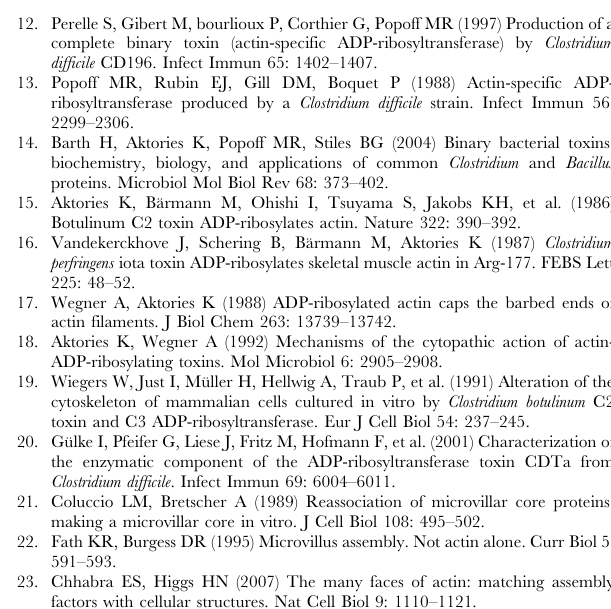
(green) by using anti-CLIP-115 antibody in Caco-2 cells are shown. The nucleus was stained by DAPI (blue). Scale bar represents 20 m m. The increase of EB3 and CLIP-115 comet length after toxin treatment is seen. Figure S7 CDT increases bacterial loads of C. difficile in cecal content in vivo . Mice were infected by gavage with Nap1/027 (10 7 CFU) and subsequently treated with control serum or CDT- neutralizing anti-iota toxin serum. Cecal content was aseptically removed and homogenized. Bacterial loads in the cecal content from uninfected untreated mice, Nap1/027 (10 7 CFU) infected CDT-neutralizing anti-iota toxin serum treated mice and Nap1/ 027 infected control antiserum treated mice were determined by plating on C. difficile selective agar plates at different dilutions. The minimal detectable value was 10 CFU/g. The experiments were performed on 2 independent occasions with a total of 10 Nap1/ 027 infected mice treated with anti-iota CDT-neutralizing serum, 11 Nap1/027 infected mice treated with control serum and 4 control mice. Boxes indicate 25th and 75th percentiles, black bars indicate medians, and whiskers indicate data ranges. Y-axis is scaled logarithmically (log 10 ). * indicates p # 0.05. Figure S8 CDT increases adherence of C. difficile in the cecum and colon in vivo . (A) Mice were infected with Nap1/027 (10 7 CFU) and subsequently treated with control serum or CDT- neutralizing anti-iota toxin serum. Cryosections (7 m m) of PFA- fixed and cryo-embedded tissue from cecum and colon were immunostained for C. difficile . Actin was stained by TRITC- phalloidin and the nuclei by DAPI. M marks the mucosa and L marks the lumen of the intestine. White boxes are magnified. White arrows mark bacteria or bacterial aggregations adjacent to the epithelium. Calibration bar represents 20 m m. (B) Quantifica- tion of C. difficile directly adjacent to the epithelium in the cecum. For bacterial quantification, bacteria adjacent to the epithelium, stained with anti- C. difficile serum, within 3 m m of the epithelium were counted. If bacterial aggregations were attached to the epithelium all bacterial cells in the aggregation were counted. This was done for $ 15 optical fields per group. The number of C.